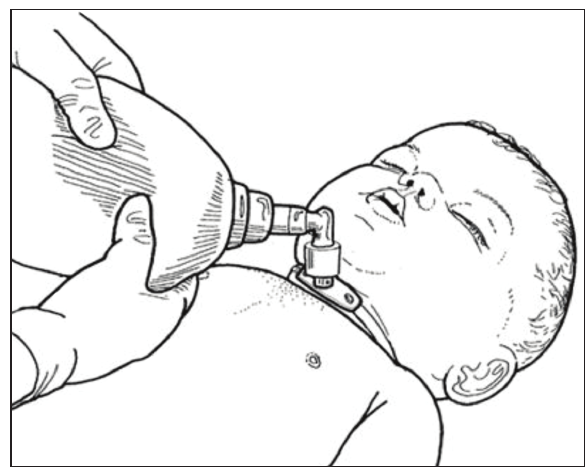
Figura 1 - Ilustração da hiperinsuflação manual Fonte: Center for Pediatric Emergency Medicine (CPEM); ilustração de Susan